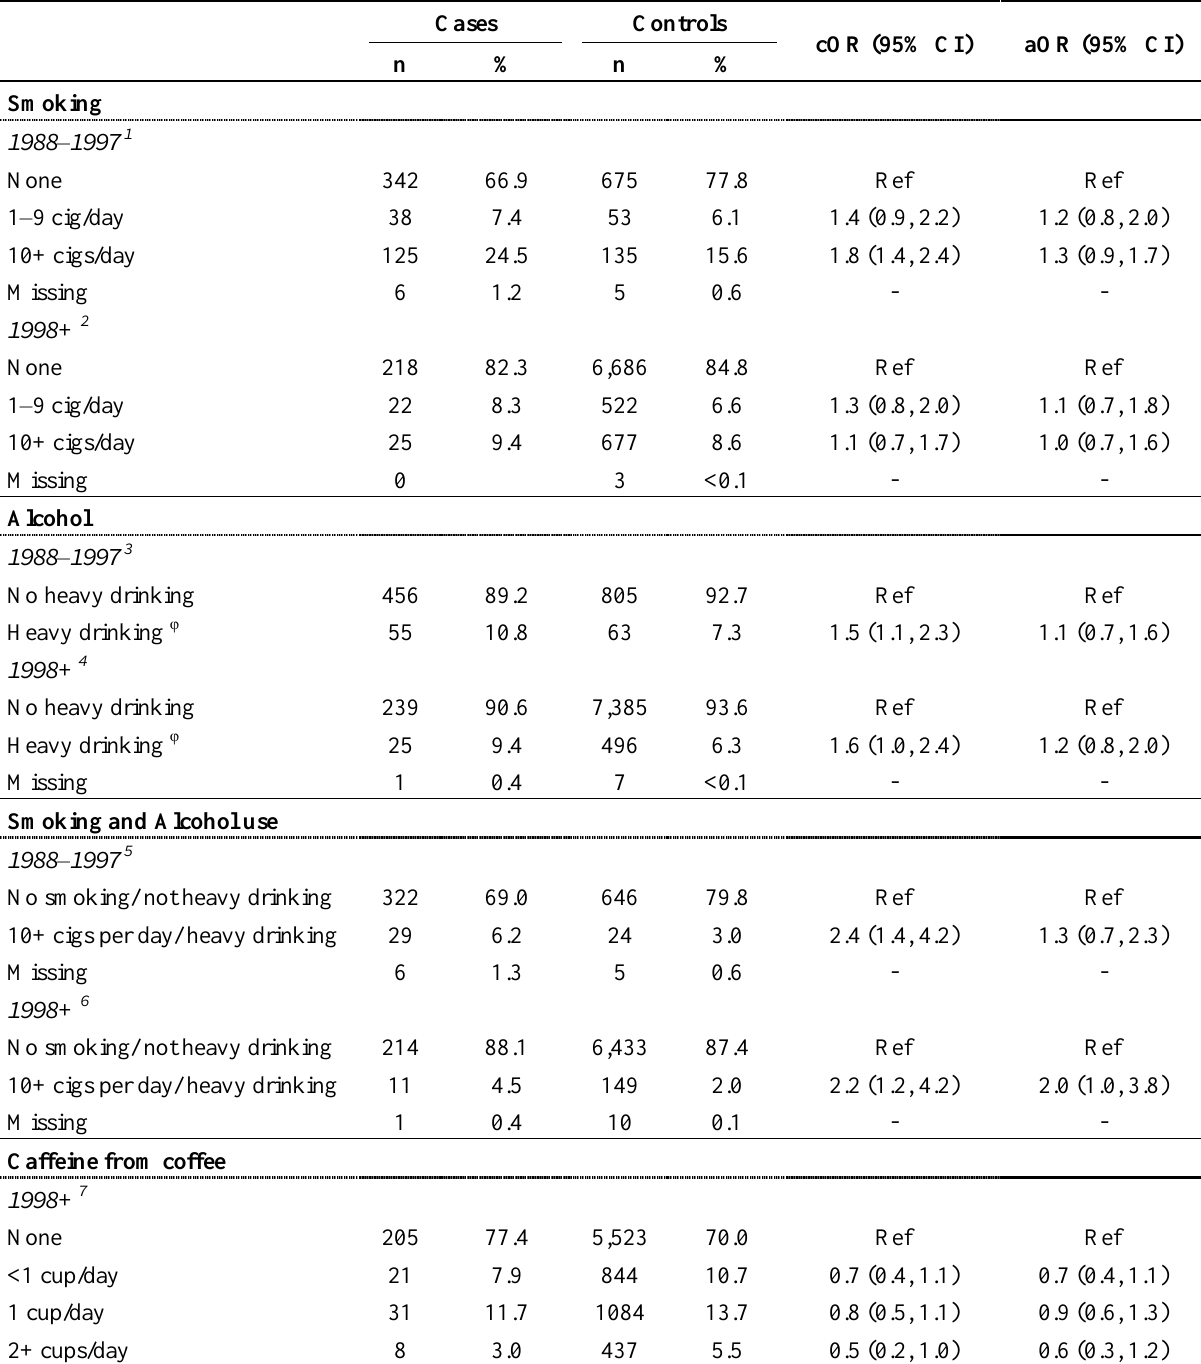
Table 3. Association between Spina Bifida and Alcohol, Smoking, and Caffeine During the First Month of Pregnancy, Birth Defects Study,